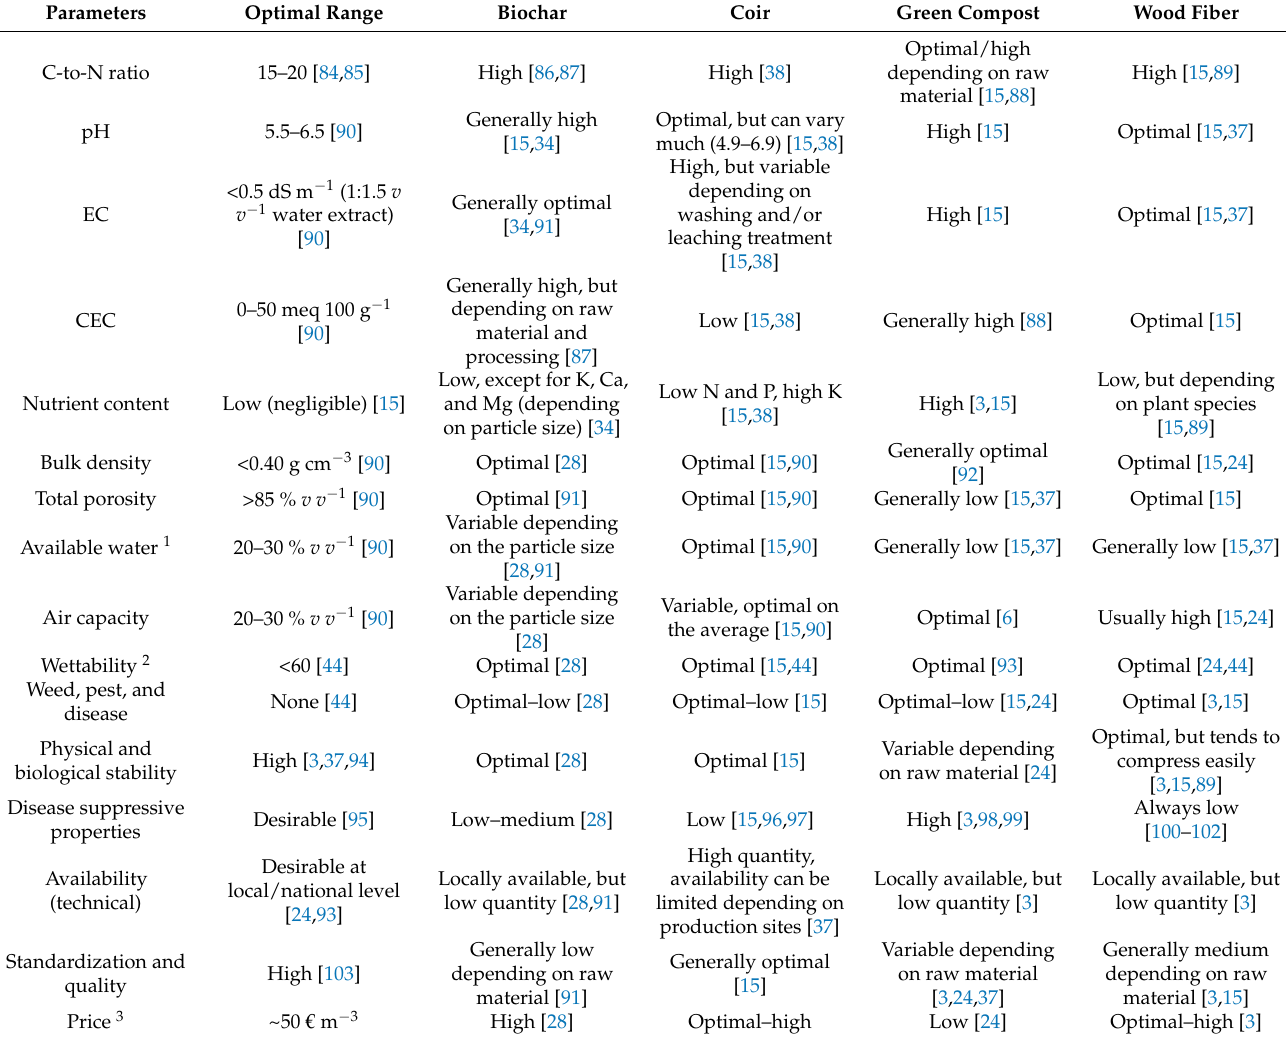
Table 1. Evaluation of the main characteristics of the four reviewed plant-based materials in respect to optimal reference values for growing